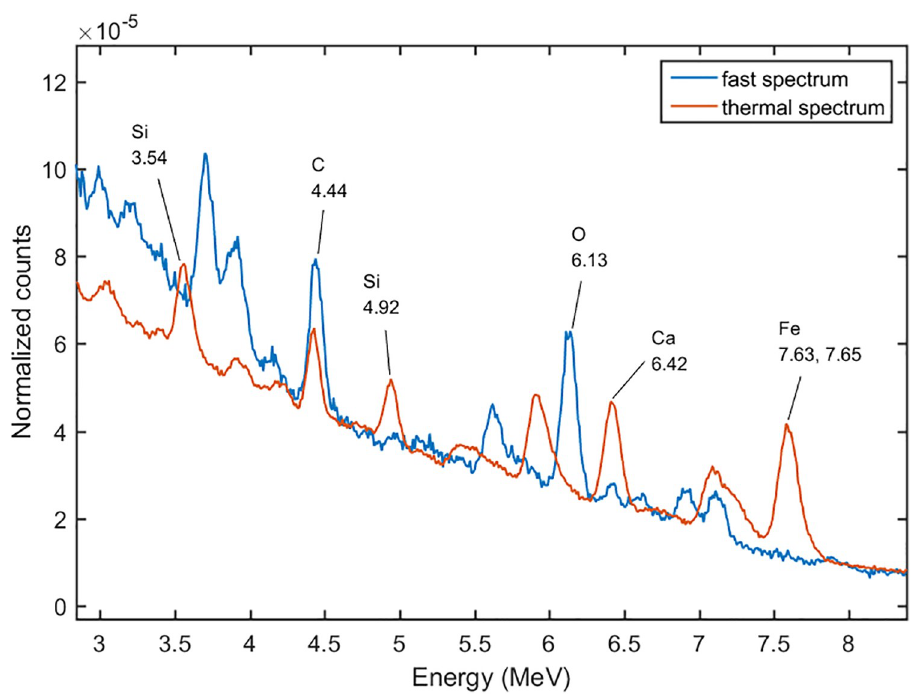
Fig 8. The gamma-ray spectra at different time intervals at the energy range of 3 to 8 MeV.